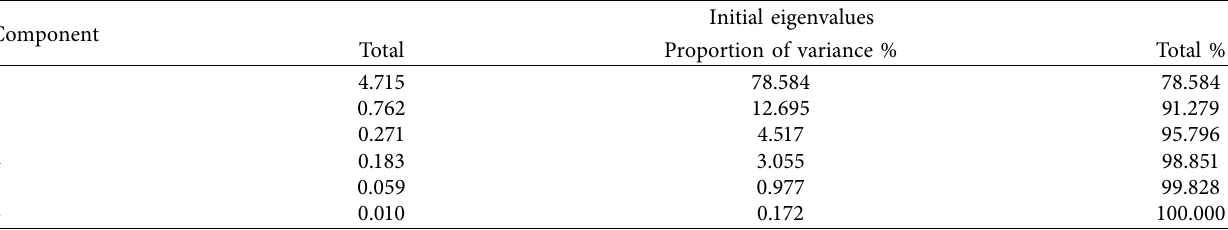
Figure 7: Probability of rock burst of different intensities for each microseismic indicator. (a) Cumulative number of events. (b) Mi- croseismic event rate. (c) Cumulative microseismic energy. (d) Microseismic energy rate. (e) Cumulative apparent volume. (f) Apparent volume rate. Table 2: Total variance of the interpretation.